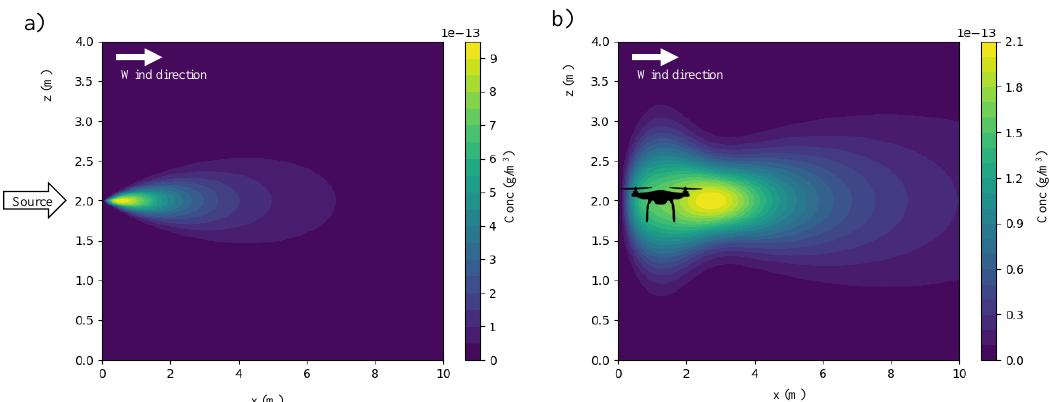
Figure 1. ( a ) False-color map of the distribution of pollutant emitted from a source placed at 2 m above ground (see arrow). ( b ) Same conditions but with the unmanned aerial vehicle (UAV) placed at the same height as the source but at 1-m distance along the x -axis. Contours are from the model (Equation 1). Please note that the scales of (a) and (b) are different to facilitate the reader's eye.